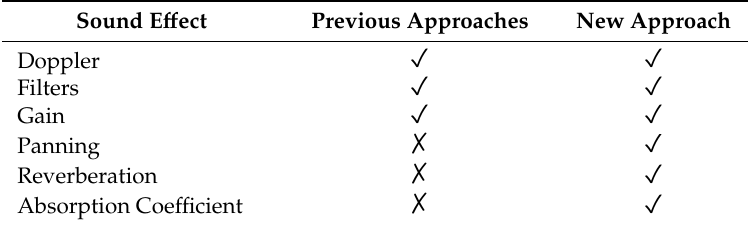
Table 1. Comparison of sound effects between the paper implementation and the previous approaches.